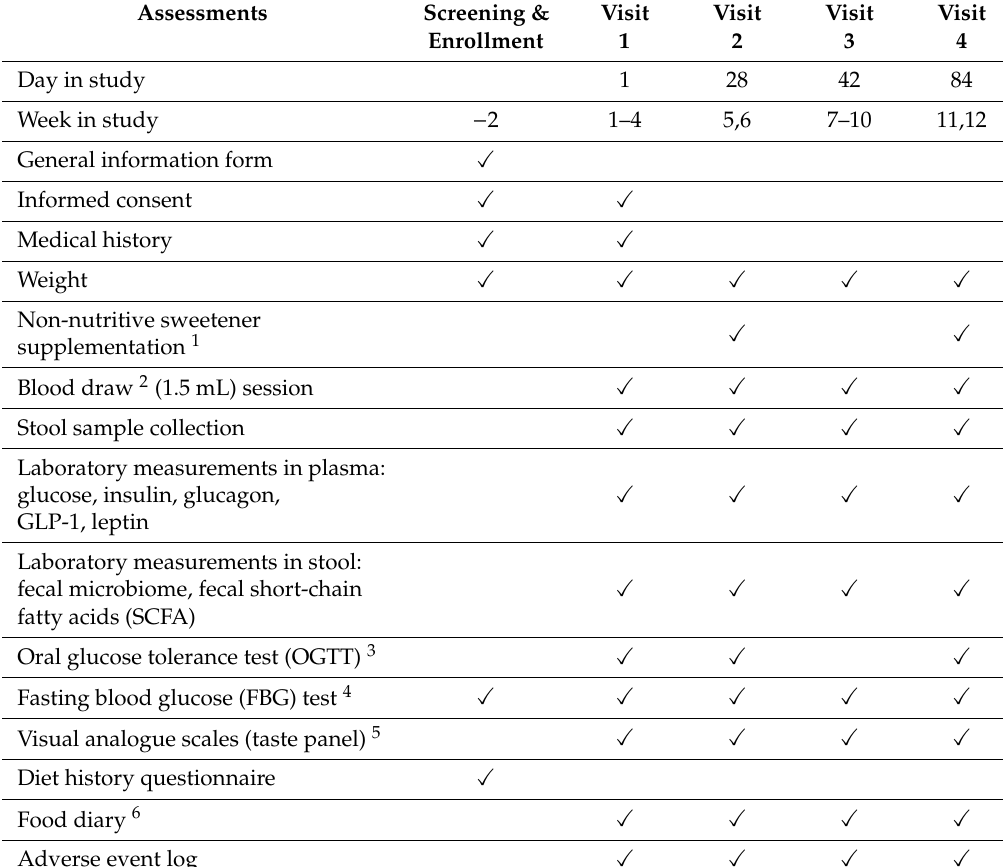
Table 1. Summary of the study schedule for enrolment, intervention and